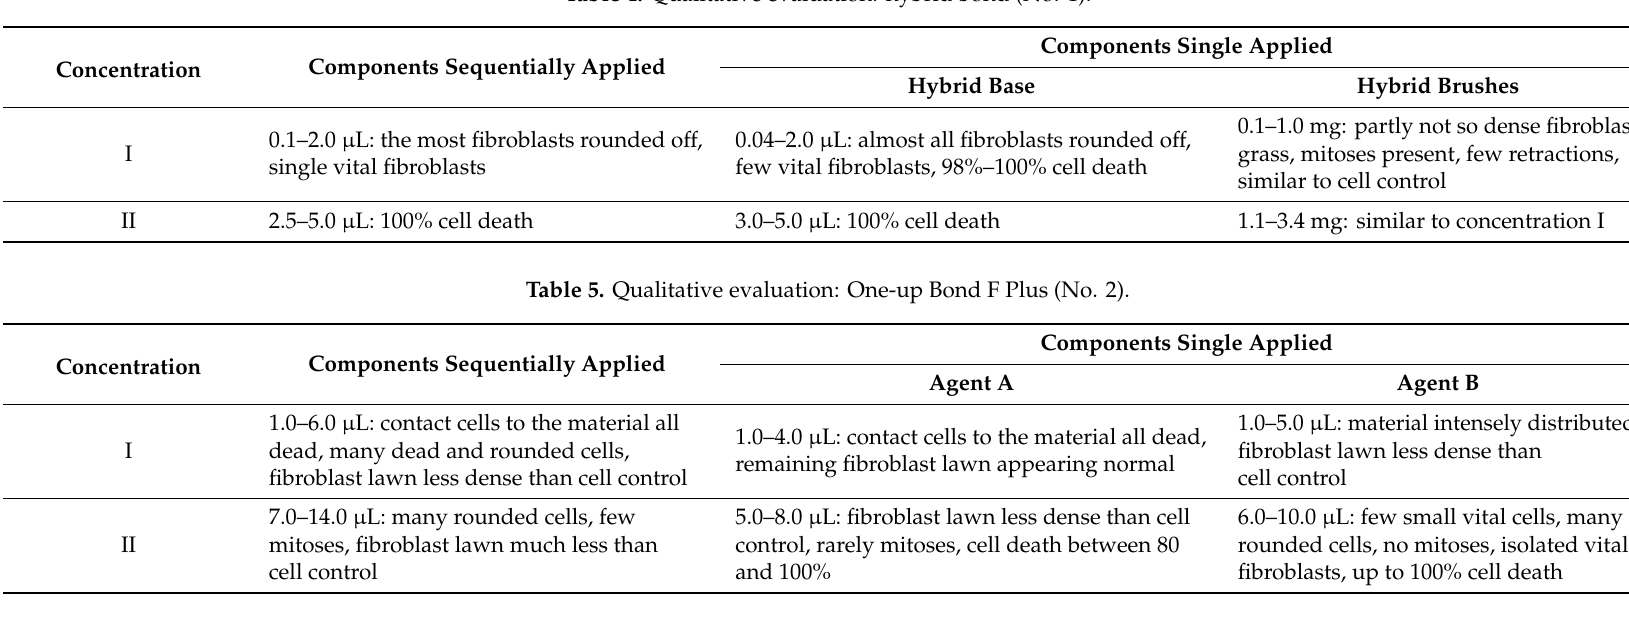
Table 6. Qualitative evaluation: AdheSE (No.